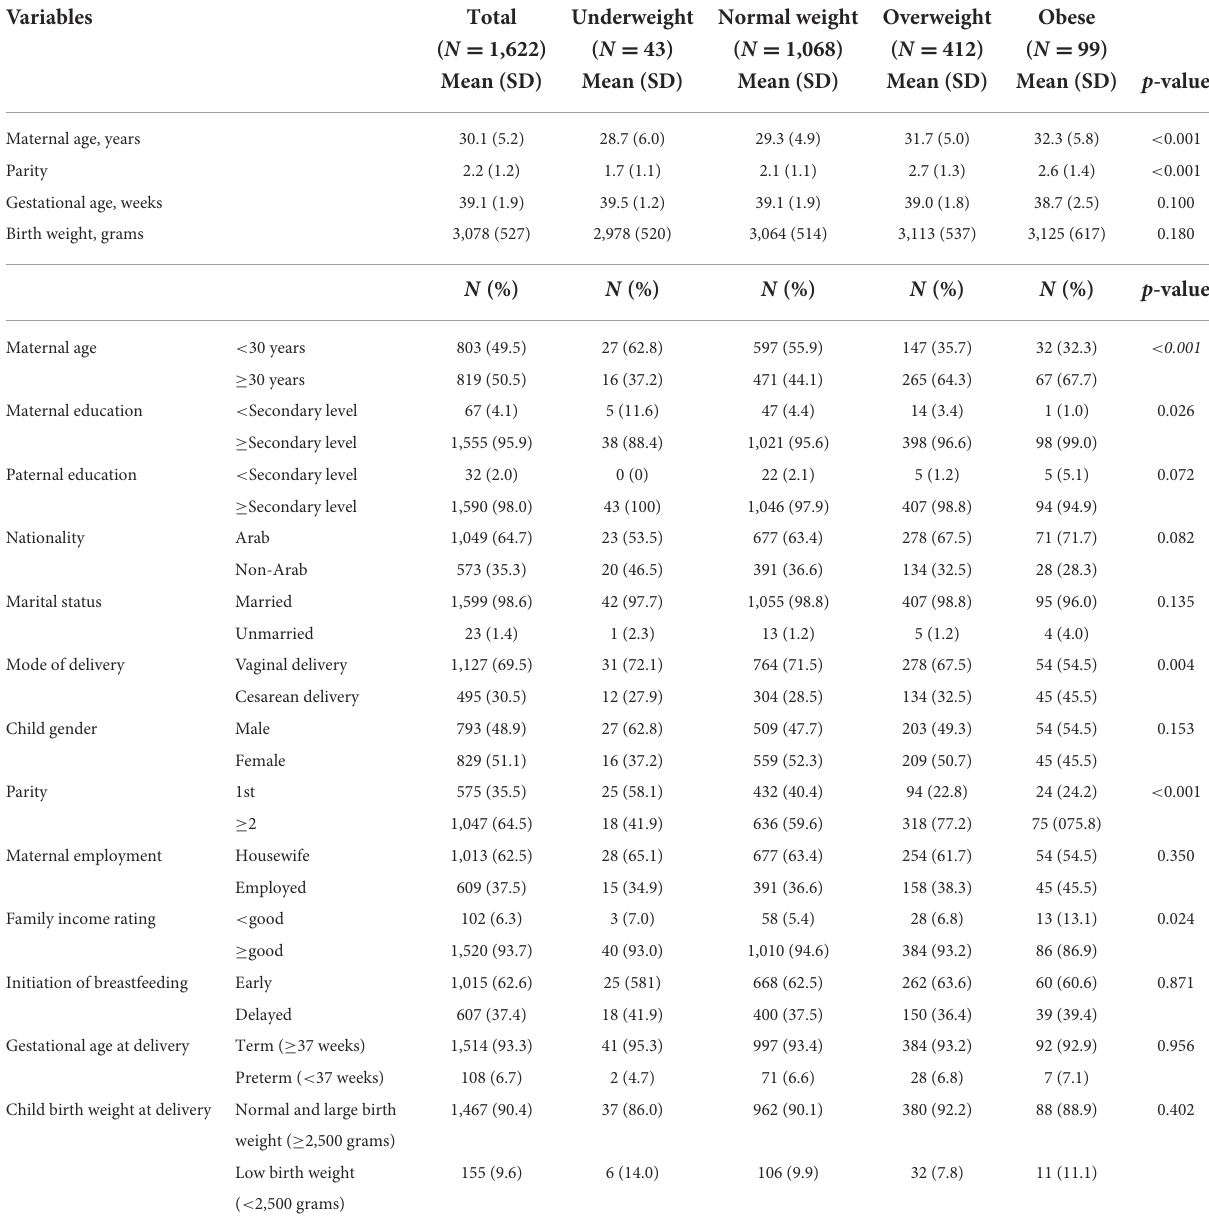
TABLE 1 Sociodemographic characteristics of the studied participants in the different pre-pregnancy BMI subgroups in Abu Dhabi, the United Arab Emirates. Variables Total Underweight Normal weight